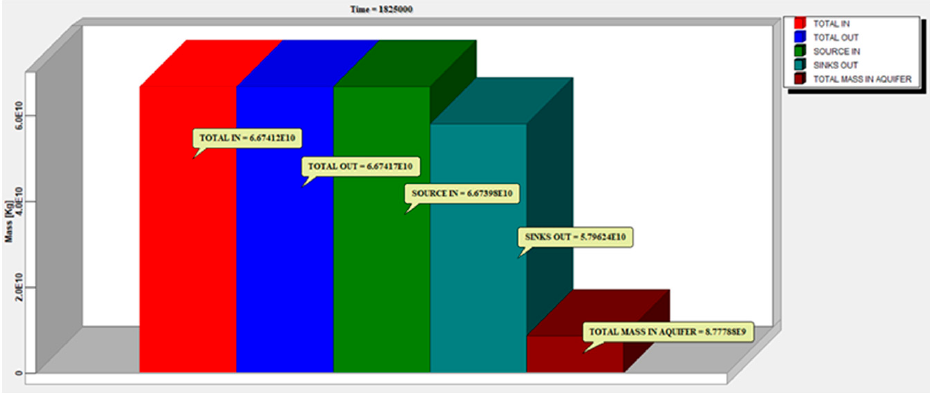
Figure A3. Location of observation wells in the ENDA ( a ) Head observation wells ( b ) Contamination observation wells.